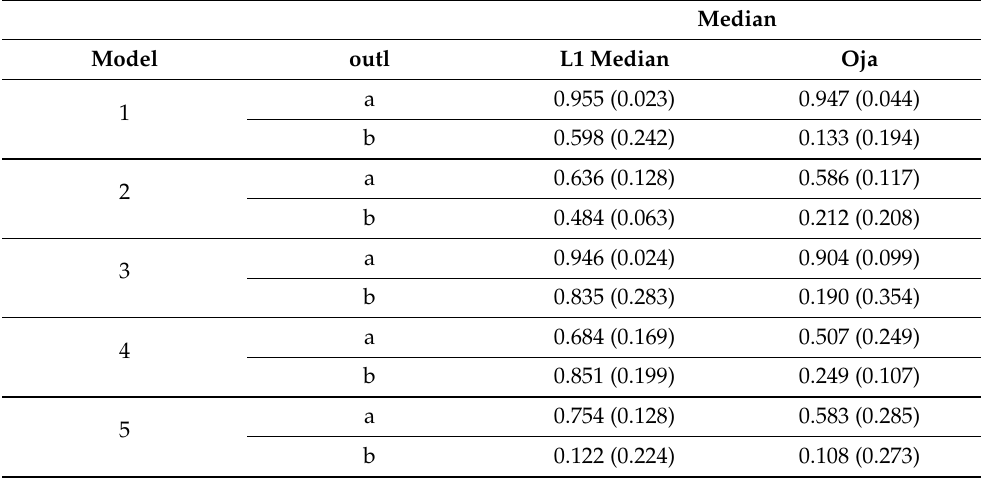
Table 2. Mean and standard errors (in parentheses) of trace correlation (4) for 100 replications for the performance of CUMed using L1 and Oja medians for all five models with and without outliers. n = 200 and p = 10.